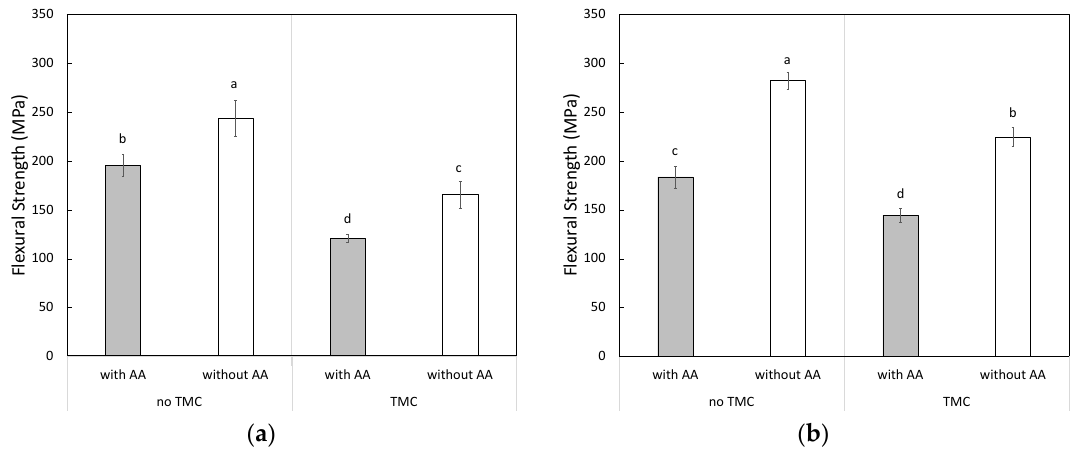
Figure 3. Mean flexural strength values of the single-bar specimens for ( a ) Shofu HC Hard (SH) and ( b ) Cerasmart 300 (CE), as illustrated in Figure 1a. The vertical error-bars indicate standard deviations. The different letters indicate a significant difference between the groups ( p < 0.05, Tukey test, n = 12). AA: alumina air-abraded specimen. TMC: 20,000-thermocycled specimen. No-TMC: 0-thermocycled specimen.